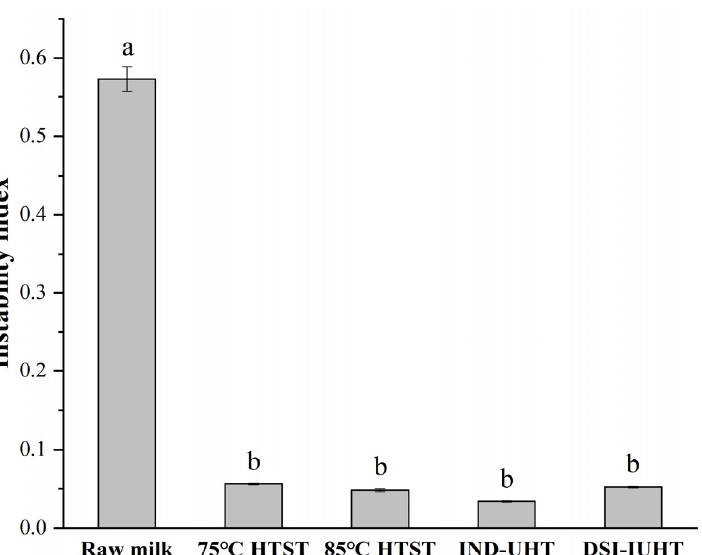
Figure 2. Instability index of the milk determined via a LUMISizer after heating at different tempera- ture/time combinations. The different letters of the instability index indicate significant differences ( p < 0.05).